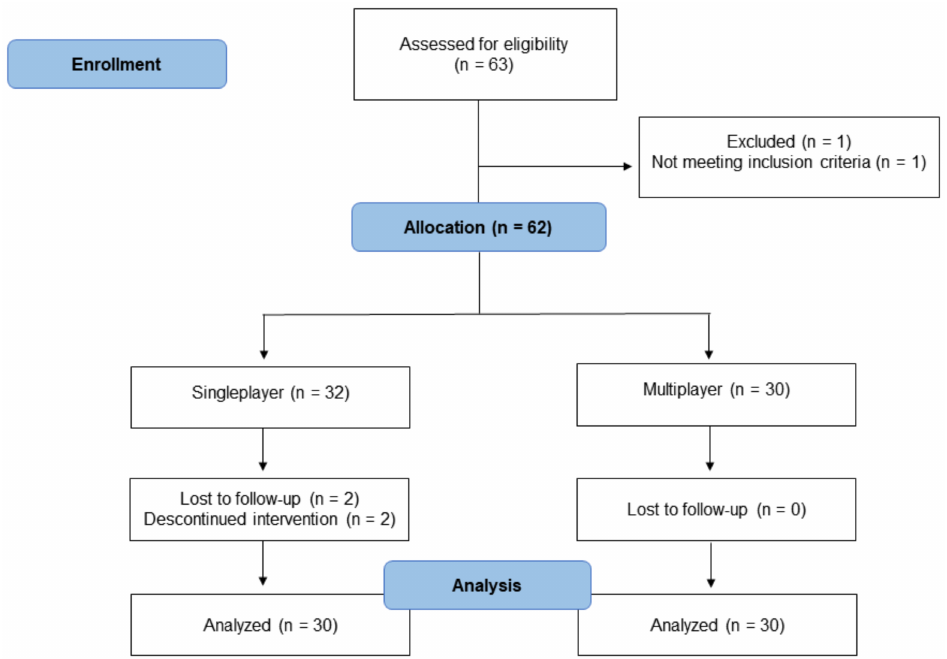
Figure 1. Flow diagram of the